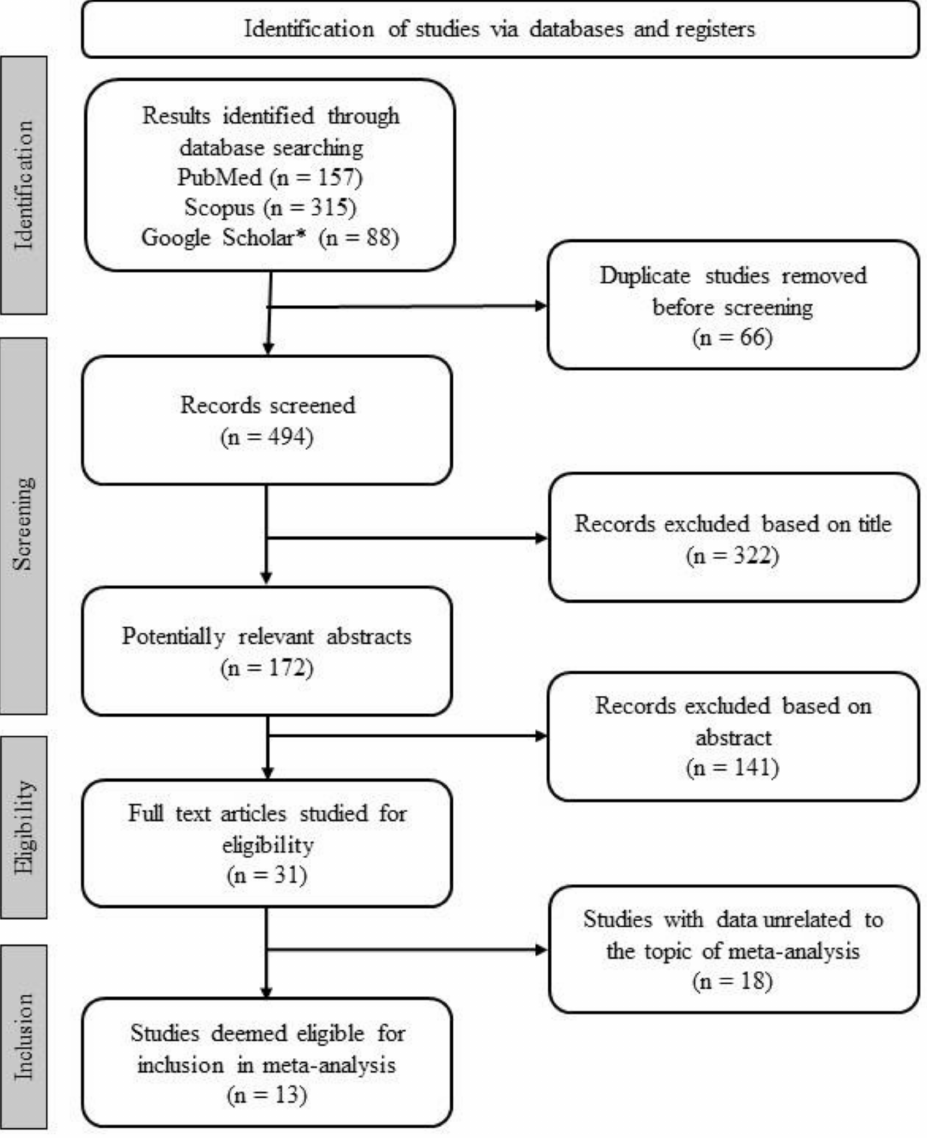
Figure 2. Flowchart of the study selection process. * The advanced function of Google Scholar was used to retrieve